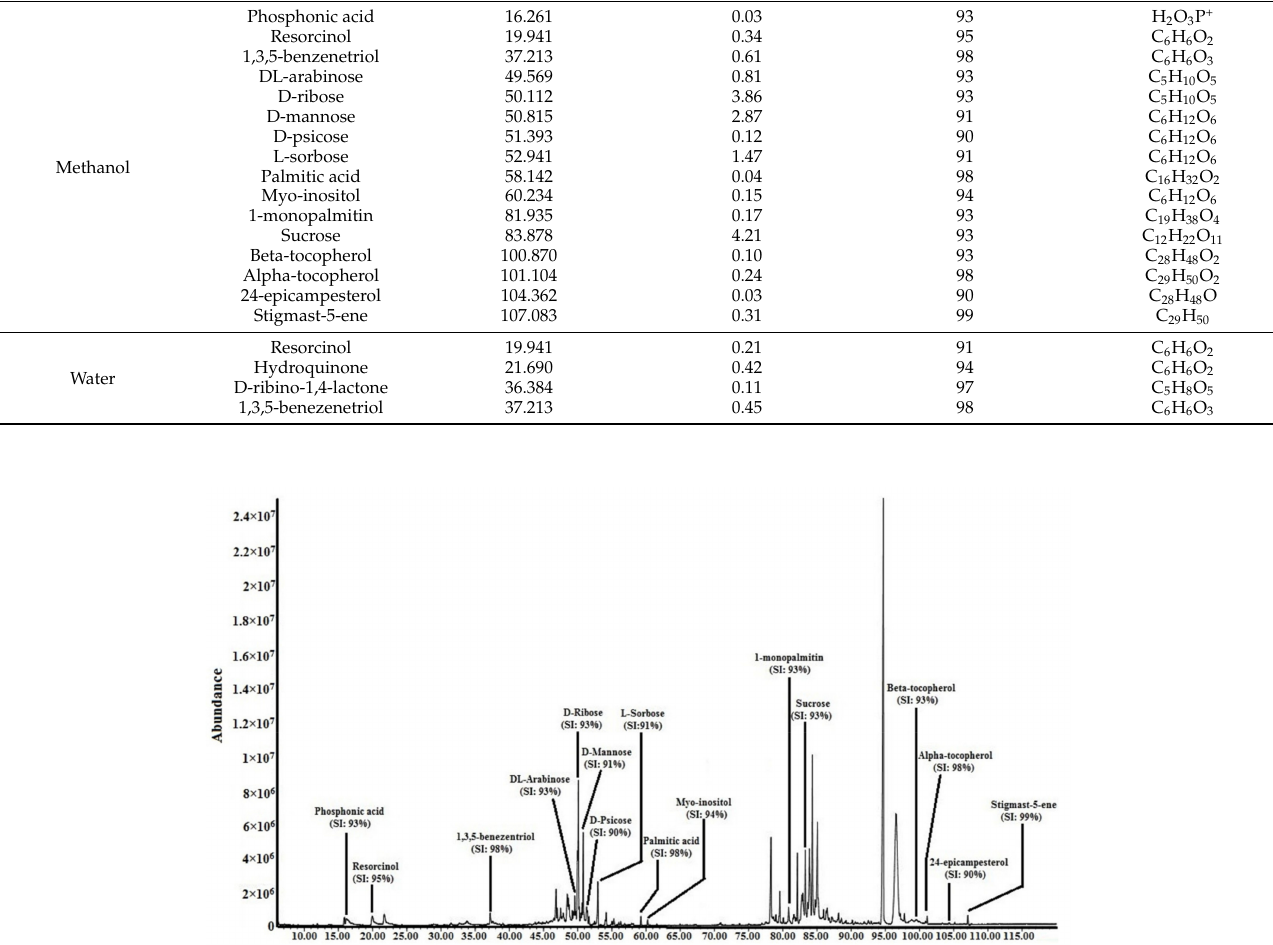
Table 6. Putative compounds identified in the methanol and water extracts of P. malayana leaves by GC-MS after derivatization. Extracts Putative Compounds Retention Time (min) % of Area Similarity Index Molecular Formula